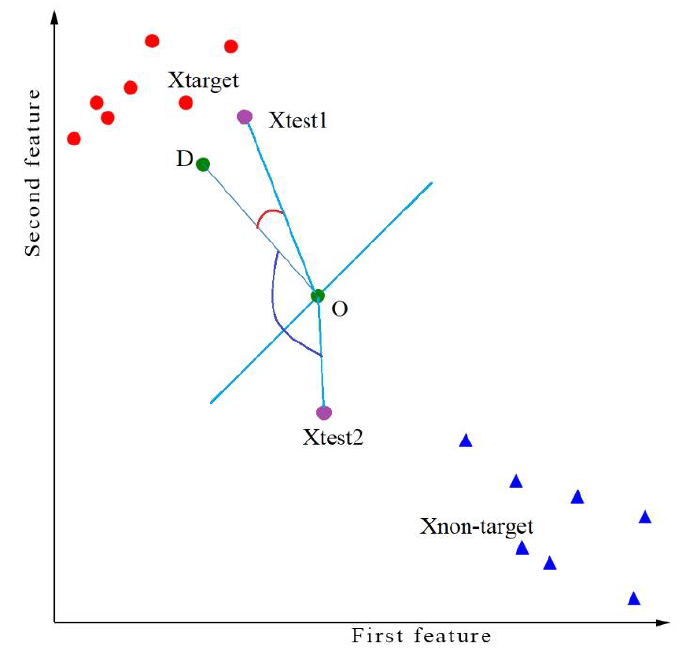
Figure 11. Classification of the test data points using the trained